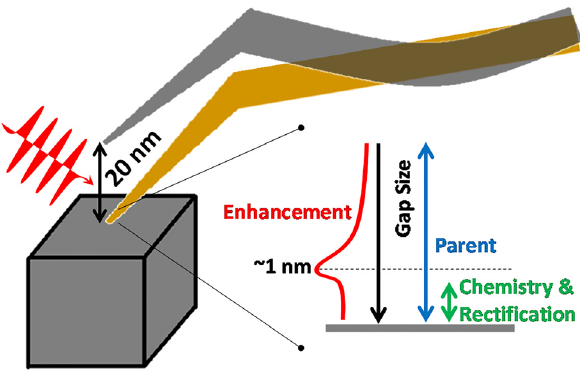
Figure 11: Local optical field properties as inferred from molecular signatures in contact versus tapping mode TERS